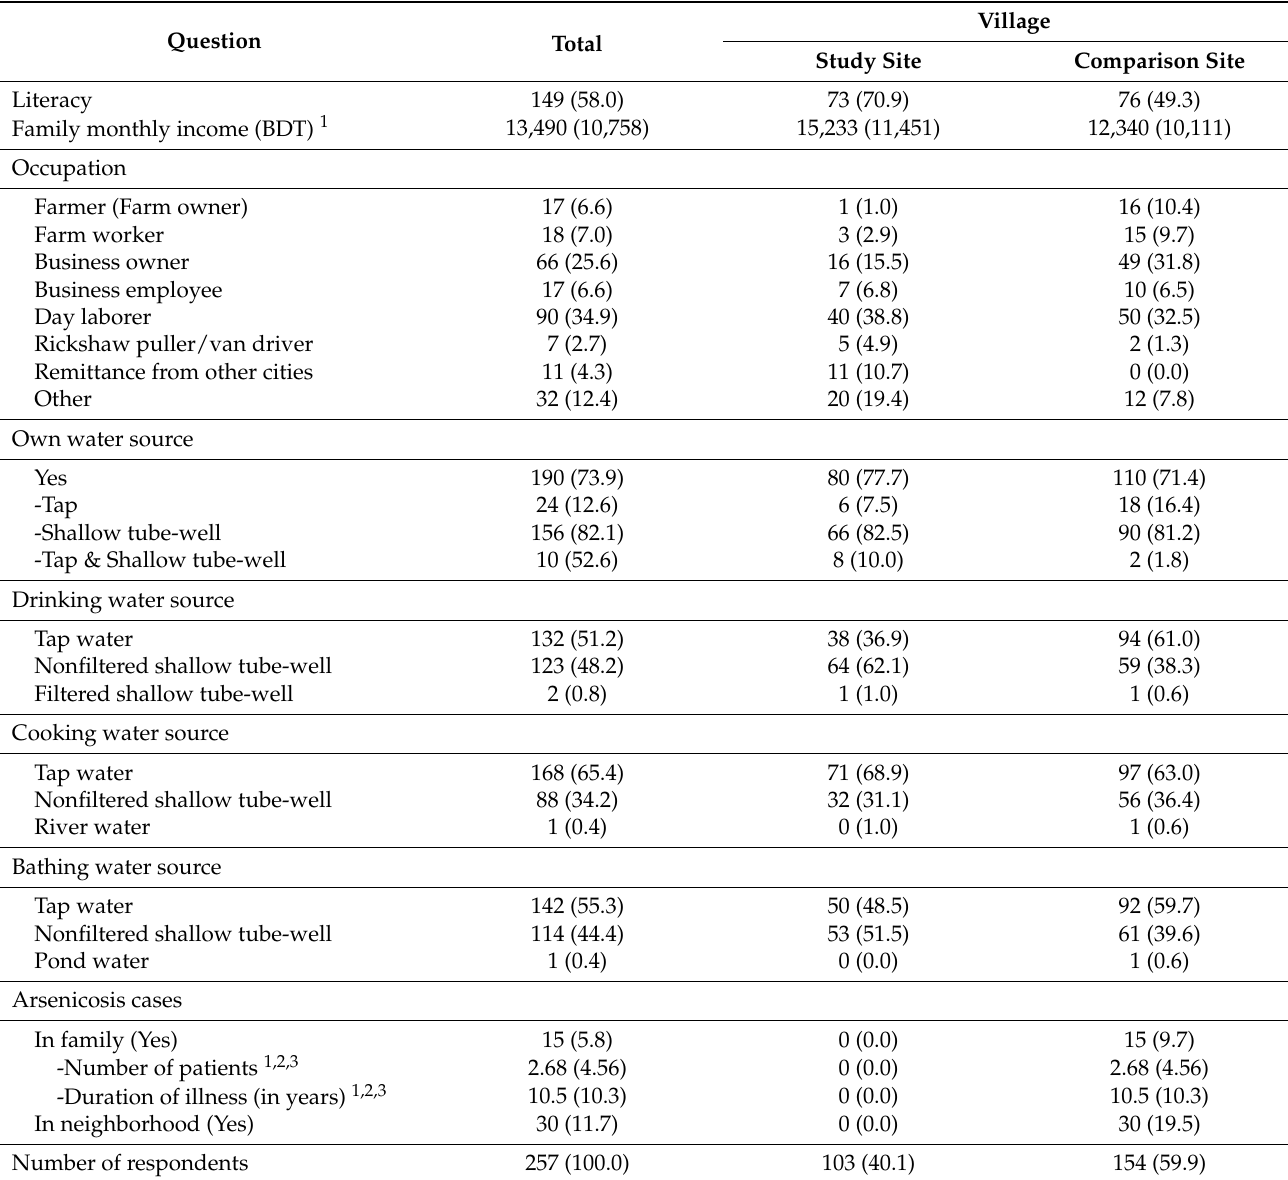
Table 3. Descriptive statistics of the questionnaire